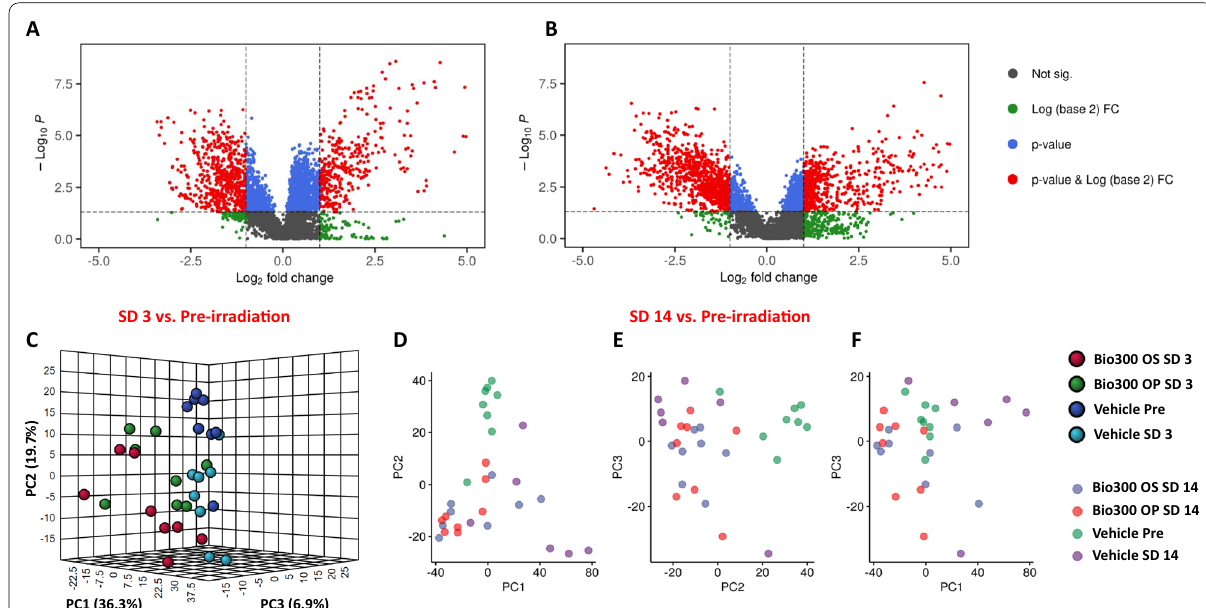
Fig. 4 Multivariate analysis of metabolomics data showing clustering patterns between and across different treatment groups and pre- and post-irradiation time points. Panel A Volcano plot showing radiation effect on all detected features at SD3. Panel B Volcano plot illustrating radiation effect on all detected features at SD14. Panel C 3D Principal Component Analysis (3D-PCA) plot demonstrating the radiation effect on fecal detected features and the radioprotection of BIO 300 at SD3. Panel D 2D Principal Component Analysis (2D-PCA) PC 1 and PC 2 plot displaying the radiation effect on fecal detected features and the radioprotection of BIO 300 at SD14. Panel E 2D Principal Component Analysis (2D-PCA) PC 2 and PC 3 plot displaying the radiation effect on fecal detected features and the radioprotection of BIO 300 at SD14. Panel F 2D Principal Component Analysis (2D-PCA) PC 1 and PC 3 plot displaying the radiation effect on fecal detected features and the radioprotection of BIO 300 at